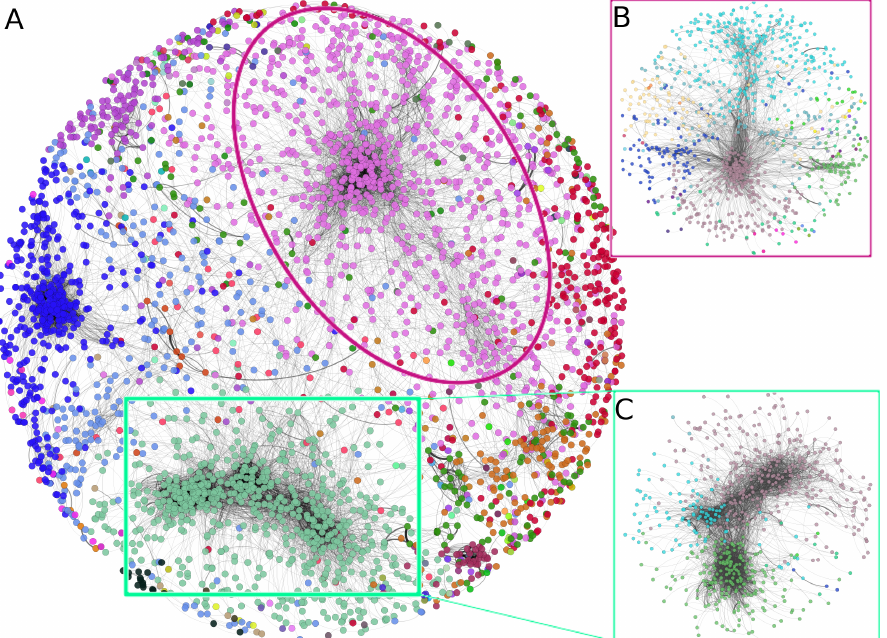
Figure 3. Hierarchical community structure of the PCN. ( A ) Communities at the first level in the